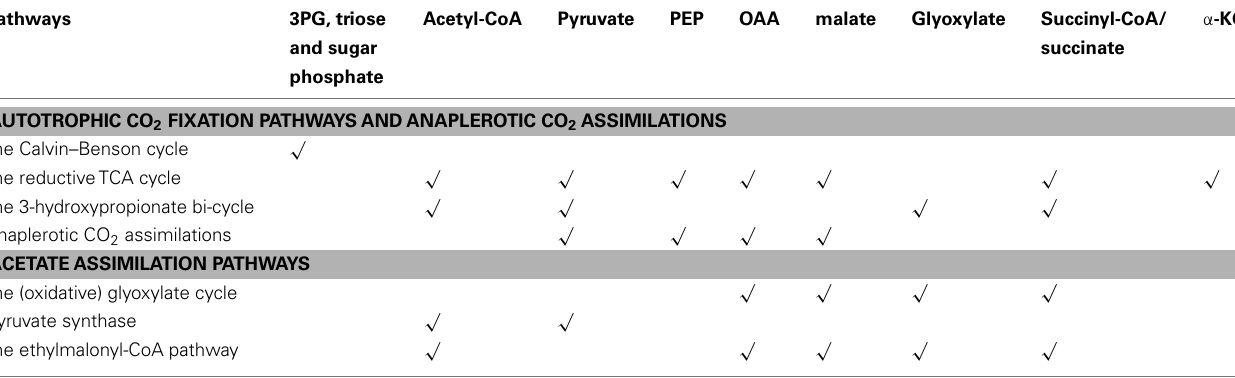
Table 2 | Metabolites generated from CO 2 and acetate assimilation pathways for producing cellular material in phototrophic